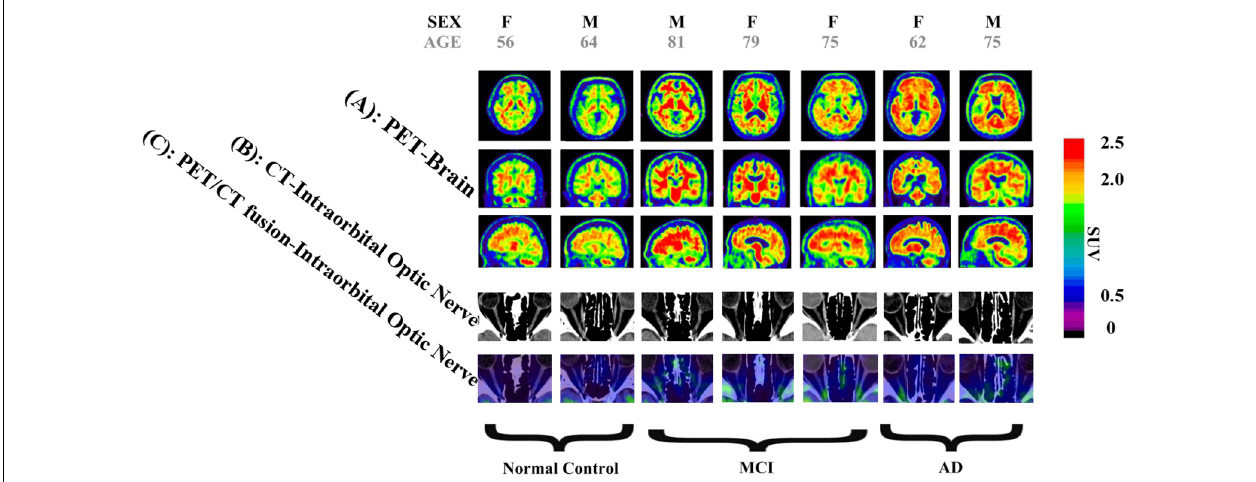
FIGURE 2 | Images of two normal controls (NCs), three subjects with mild cognitive impairment (MCI), and two subjects with Alzheimer’s disease (AD). (A) Brain positron emission tomography (PET) images, showed that: (1) Among images of NC subjects, there is more 18 F-flutemetamol radioactivity in the white matter than in the gray matter of bilateral occipital lobes, creating clear gray/white matter contrast. (2) Some areas of the gray matter 18 F-flutemetamol radioactivity of bilateral occipital lobes are as intense as that in the adjacent white matter among MCI subjects. (3) The gray matter 18 F-flutemetamol radioactivity of bilateral occipital lobes are as intense as that in the adjacent white matter among AD subjects. (B) CT images of bilateral intraorbital optic nerves showed that the CT density of the bilateral intraorbital optic nerves of NC, MCI, and AD subjects was gradually decreased. (C) PET/CT fusion images of the bilateral intraorbital optic nerves showed that: (1) among images of NC subjects, almost no significant 18 F-flutemetamol radioactivity was observed on the bilateral intraorbital optic nerves; (2) among images of MCI subjects, slight 18 F-flutemetamol radioactivity was detected on the bilateral intraorbital optic nerves; and (3) among images of AD subjects, 18 F-flutemetamol radioactivity was detected on the bilateral intraorbital optic nerves. TABLE 3 | The p -value of the occipital SUVR, the intraorbital optic nerve SUVR, and the intraorbital optic nerve density between each of the two groups. MCI vs. NC AD vs. NC AD vs. MCI p -value p -value p